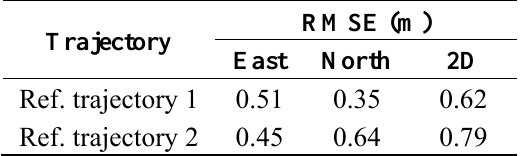
Table 4. The accuracy of the reference